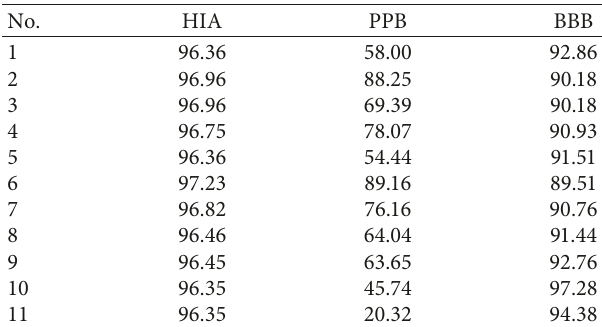
Table 6: Values of factors of biological activity (HIA, PPB, and BBB) for compounds 1 – 11 .